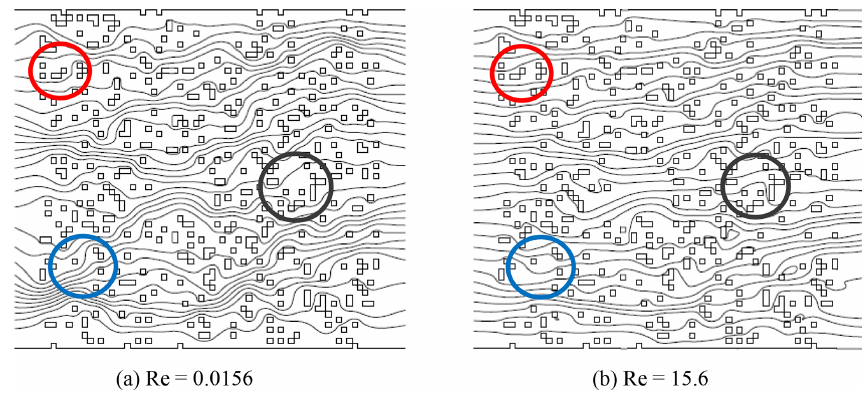
Figure 1. Two-dimensional domain containing randomly distributed obstacles (squares and rectangles). Stream functions for (a) Re = 0 . 0156 and (b) Re = 15 . 6 are shown with constant increments between consecutive streamlines (from Andrade et al., 1999; copyright American Physical Society). The different patterns of preferential pathways are clear and distinct. The three pairs of circles (red, blue, black) highlight three (of many) specific locations where the streamlines are seen to change as a function of Re